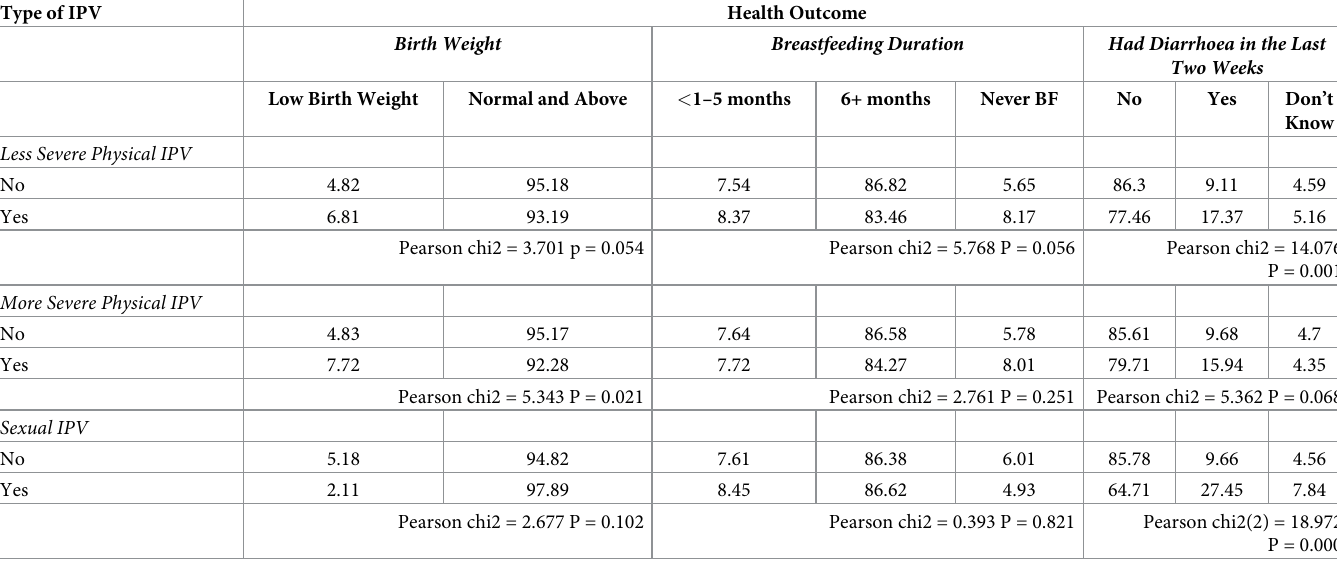
Table 1. Percentage distributions of mother’s experience of type of IPV by child health